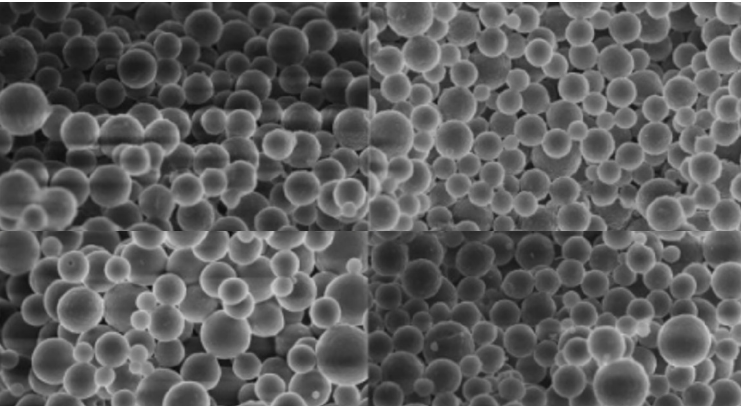
Figure 10. Spherical carbon particles.